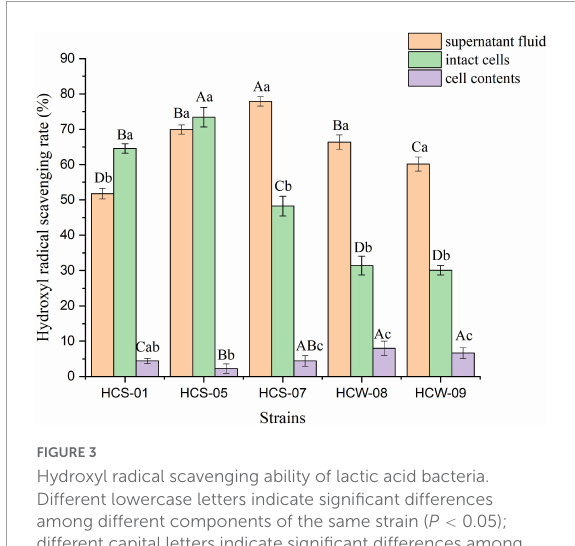
FIGURE2 2,2-Diphenyl-1-picrylhydrazine (DPPH) free radical scavenging ability of lactic acid bacteria. Different lowercase letters indicate significant differences among different components of the same strain ( P < 0.05); different capital letters indicate significant differences among the same components of different strains ( P < 0.05).